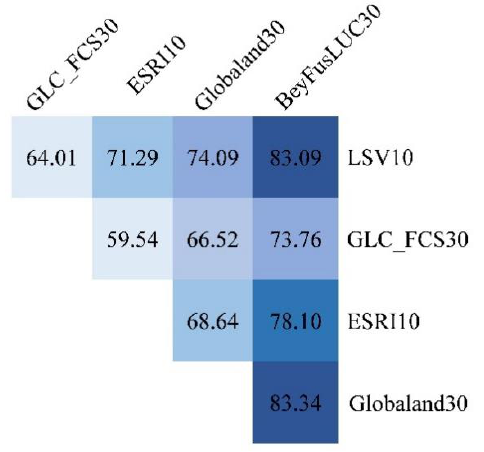
Figure 4. Overall consistency across 5